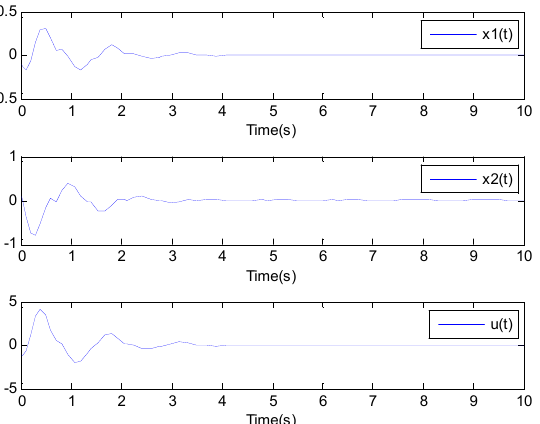
Figure 15. Evolution of the state variables x 1 ( t ) , x 2 ( t ) and the controller u ( t ) ( b = 1, a = − 14, m = 50, and δ =